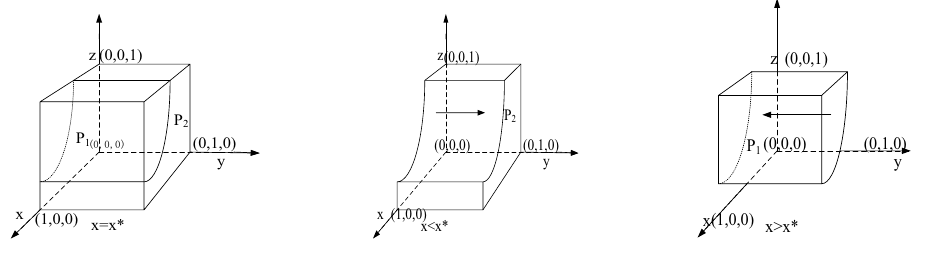
Figure 2. Strategy diagram of the